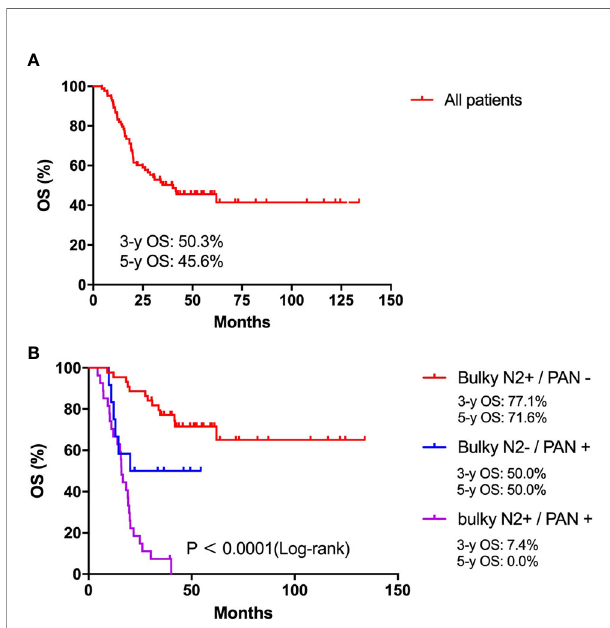
FIGURE 2 | Survival analysis. (A) Survival analysis for all patients with bulky N2 and/or para-aortic lymph node metastases. (B) Survival analysis for patients between the Bulky N2+/PAN-, Bulky N2-/PAN+ and Bulky N2+/PAN+ groups.